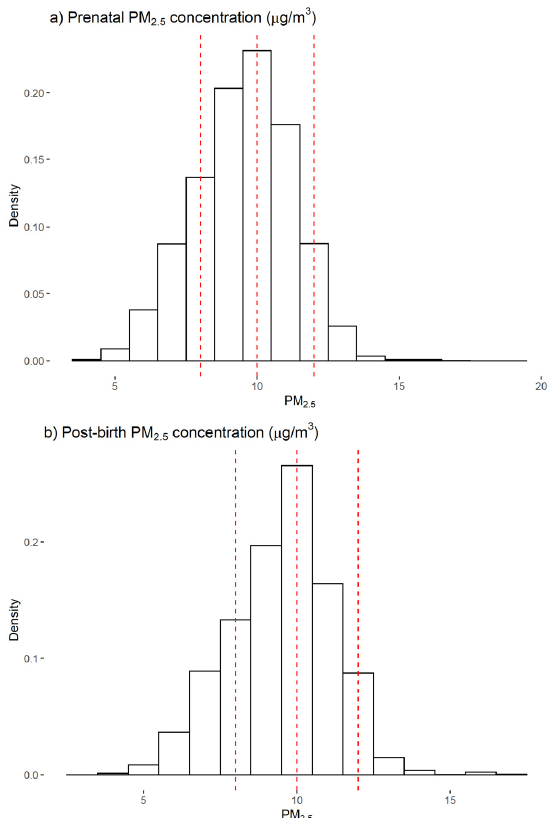
Figure A1. Distribution of average prenatal and post-birth PM 2.5 concentration; Notes: Panel ( a ) shows the distribution of average prenatal PM 2.5 exposure (defined over 9 months from the date of conception) while panel ( b ) illustrates the distribution of PM 2.5 exposure in the post-birth period (defined over 12 months from the end of the 9-month prenatal period). The red dashed lines on each histogram reflect the threshold values used to create the categorical exposure variable used in the Structural Equation Model. The first red line is at 8 µ g/m 3 , the second is at 10 µ g/m 3 , and the third is at 12 µ g/m 3 .